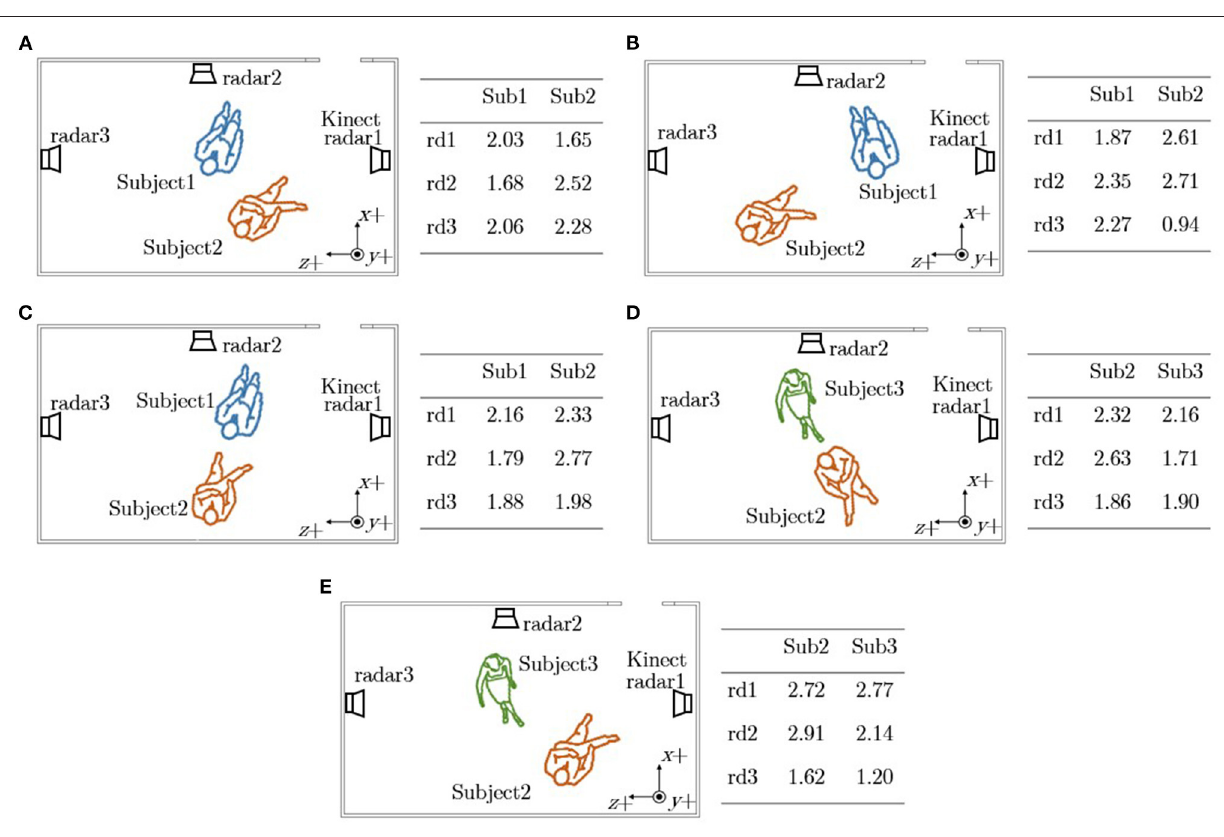
FIGURE 2 | The setup that shows the placement of radars and Kinect for the experiments of two-subjects RR estimation. The position of sensors are the same in all figures while the orientation and subject location changes. The subjects’ locations, orientations and the distances between subjects’ chests to three radars